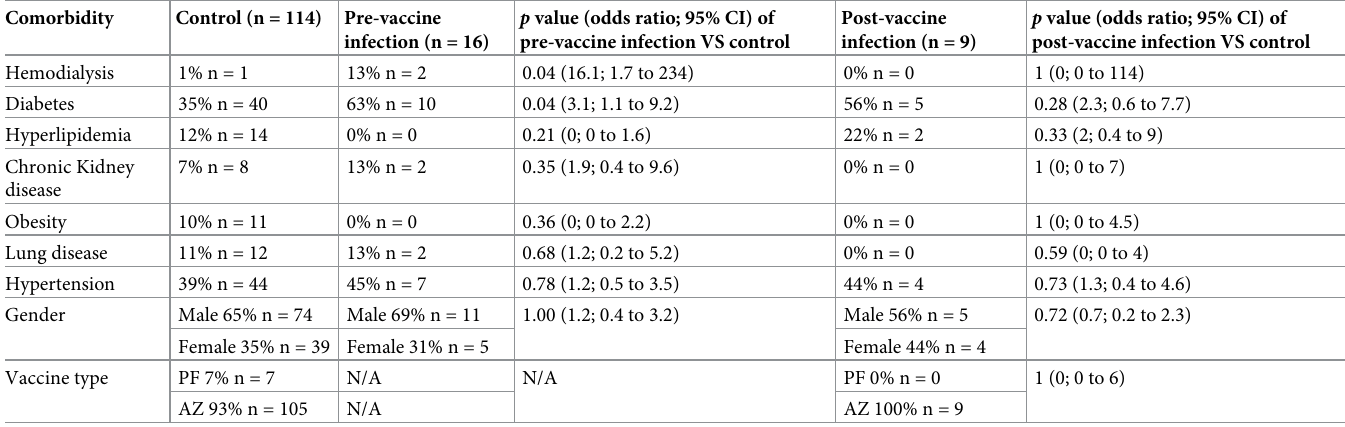
Table 1. Comorbidity